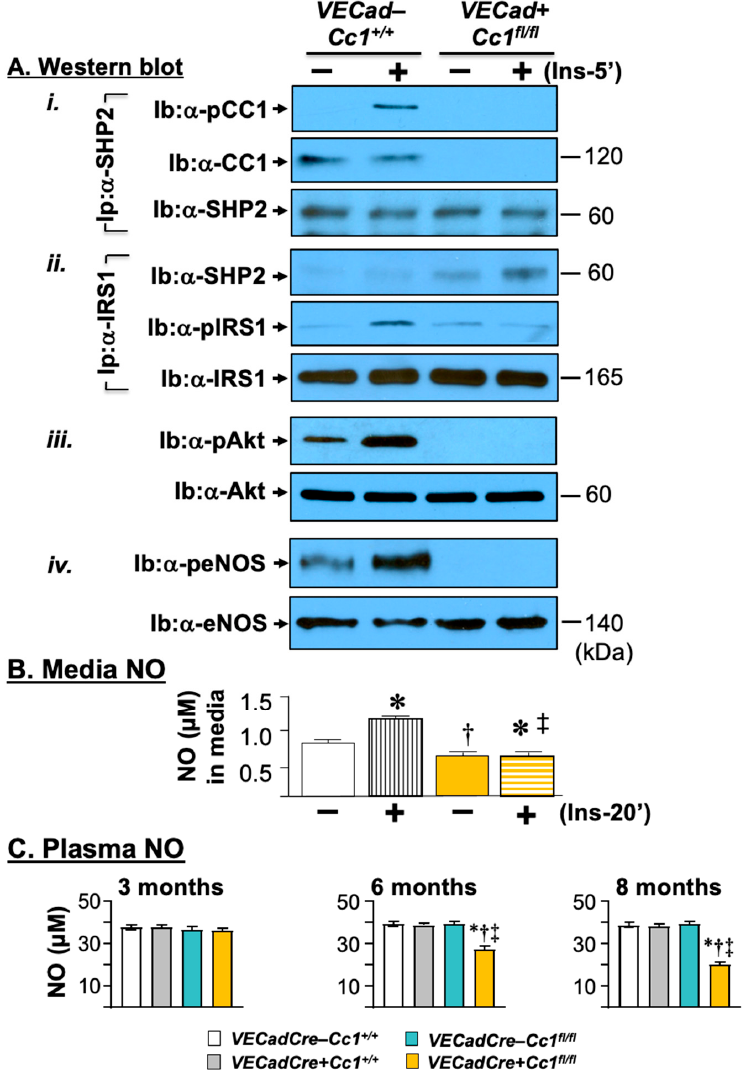
Figure 5. Insulin signaling leading to nitric oxide production in liver endothelial cells. ( A ) Primary liver endothelial cells (LEC) from 2-month-old WT ( VECad − Cc1 +/+ ) and null ( VECad+Cc1 fl/fl ) mice were treated with (Ins, 100 nM) or without insulin for 5 min before proteins were lyzed and ( i ) subjected to immunoprecipitation (Ip) with SHP2 antibody followed by immunoblotting (Ib) with antibodies against phospho-CEACAM1 (pCC1) and CEACAM1 (CC1) or SHP2 to assess the amount of CC1 and pCC1 in the SHP2 immunopellet. ( ii ) Similar co-immunoprecipitation experi- ments were performed to evaluate the association between IRS1 with SHP2. ( iii,iv ) Lysates were also subjected to immunoblotting with α -phospho-antibodies to account for activation of Akt and eNOS, respectively, as in the legend in Figure 4. Gels represent two separate experiments. ( B ) levels of nitric oxide (NO) were determined in triplicate in the media of cells treated with or without insulin for 20 min. Values are expressed as mean ± SEM. * p < 0.05 vs. no insulin/same genotype; † p < 0.05 vs. VECadCre − Cc1 +/+ no insulin; ‡ p < 0.05 vs. VECadCre − Cc1 +/+ plus insulin.( C ) Male mice (3–8 months of age, n ≥ 5/genotype) were fasted overnight before blood was drawn, and plasma was processed to assess NO levels. Values are expressed as mean ± SEM. * p < 0.05 vs. VECadCre − Cc1 +/+ , † p < 0.05 vs. VECadCre+Cc1 +/+ , ‡ p < 0.05 vs. VECadCre − Cc1 fl/fl